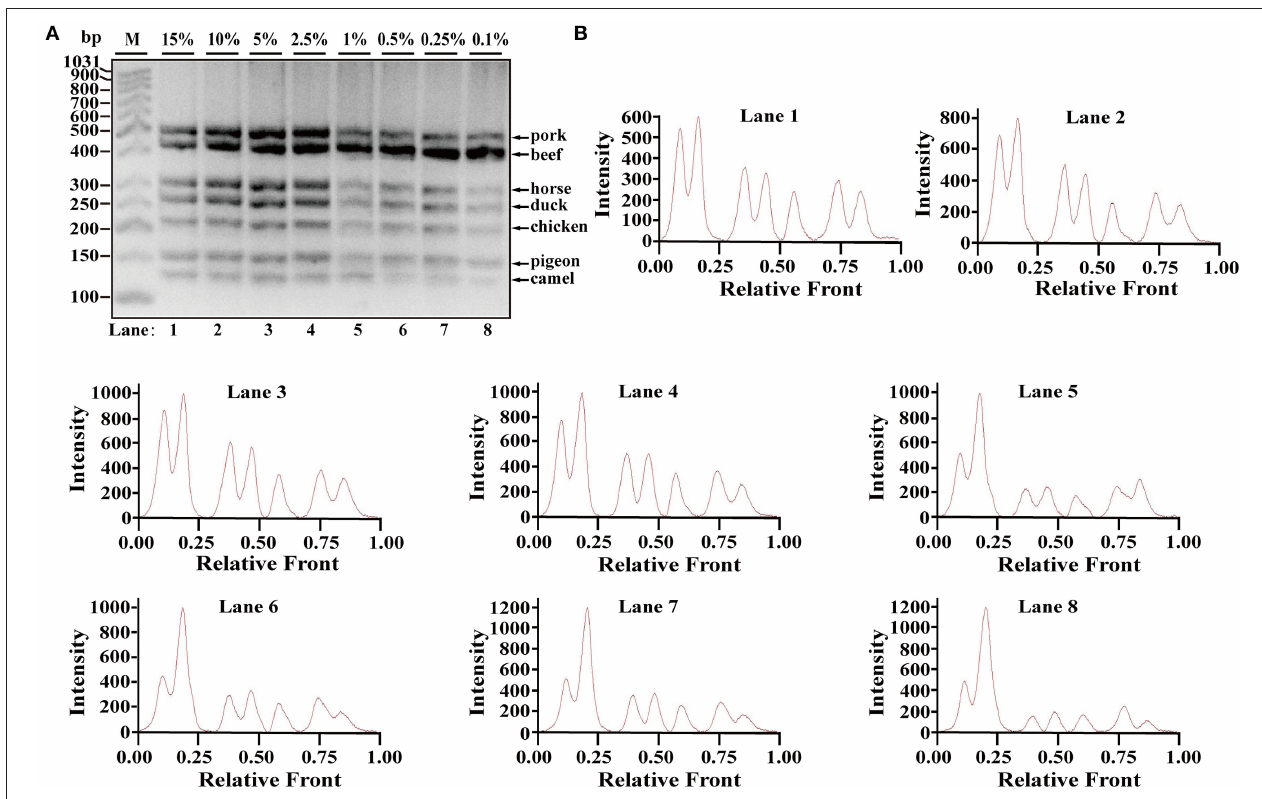
FIGURE 3 | Validation of the sensitivity of multiplex PCR assay. (A) Gel image of PCR fragments amplified by multiplex PCR using model mixtures of pork, horse, duck, chicken, pigeon, and camel added to beef at 15, 10, 5, 2.5, 1, 0.5, 0.25, and 0.1% of total weight with species-specific primers of seven meat species in a single PCR. (B) The corresponding electropherogram of gel image represented pork, beef, horse, duck, chicken, pigeon, and camel in each lane. Lanes 1–8 are presented with labels (15, 10, 5, 2.5, 1, 0.5, 0.25, and 0.1%) in (A) . The value of number at the horizontal line means the relative position of peaks distant from the top of agarose gel. The value of number at the vertical line means the fluorescent intensity of DNA-bound dyes using 4S GelRed nucleic acid stain. Lane M is ladder